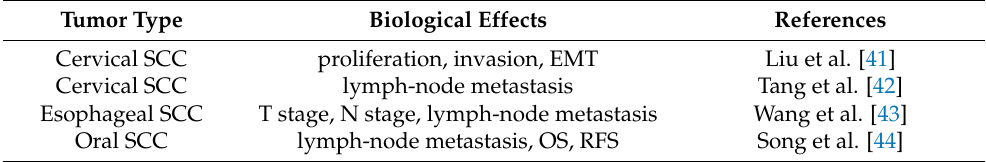
Table 3. FOXP3 in